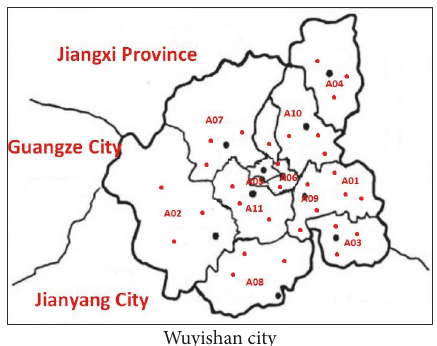
Figure 1: Tea samples collected in Wuyishan.